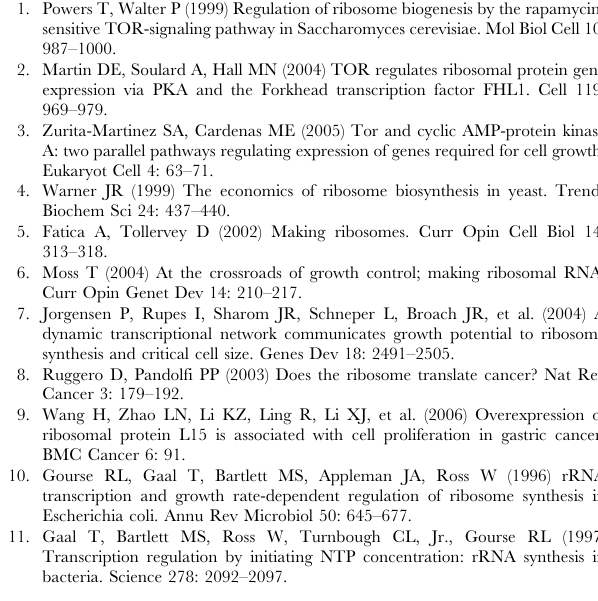
Table S3 Effect of medium limitations on the enrichment of positive and negative correlated genes with gene